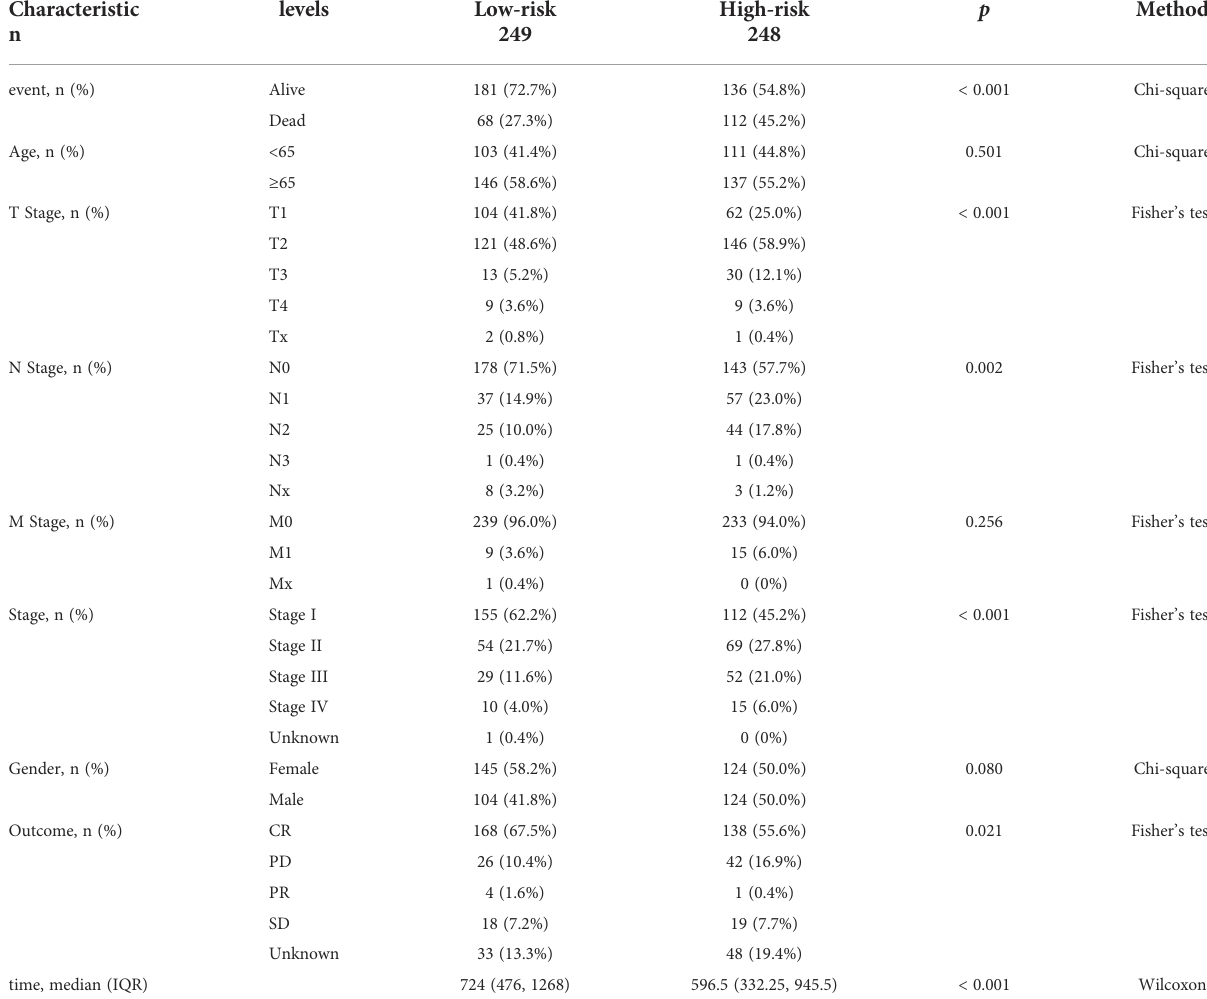
TABLE 1 Baseline characteristics and comparison of LUAD patients divided by the prognostic